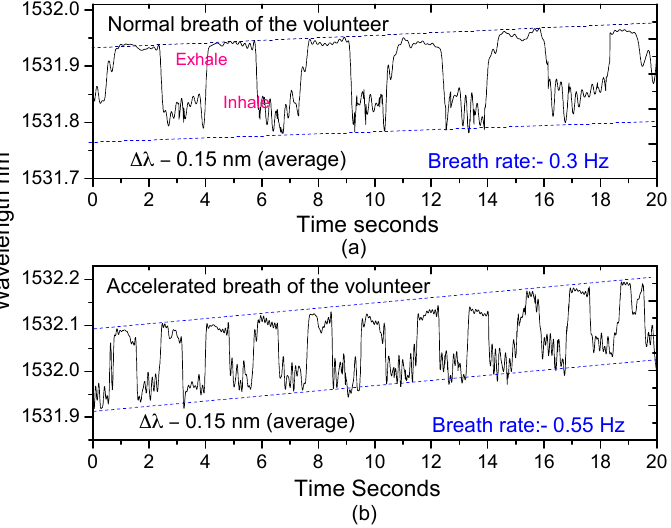
Figure 13. Etched PFBG breath rate monitoring setup. ( a ) Packaged sensor; ( b – d ) the sensor attached to a nebulizer mask.